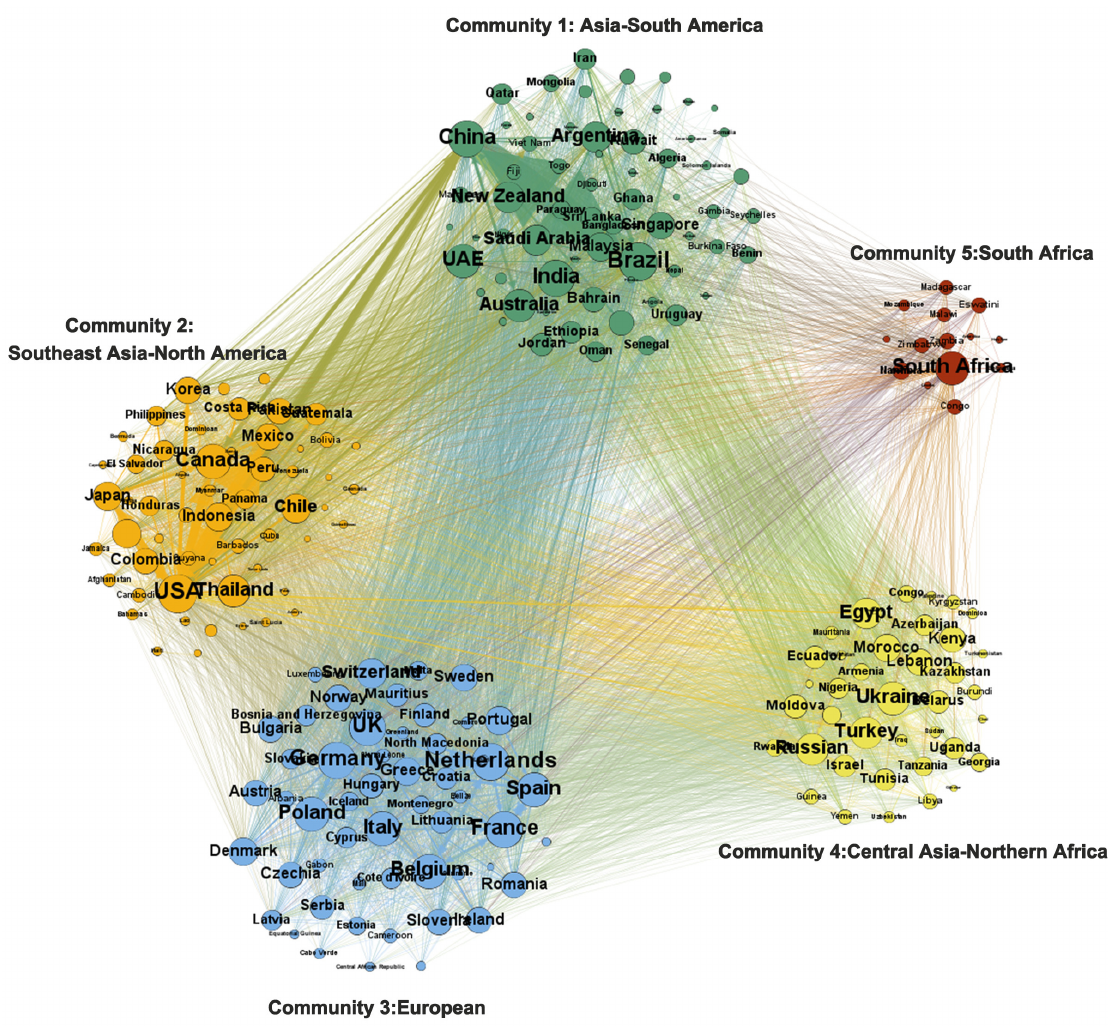
Figure 5. Trade stability of different communities in 2018.